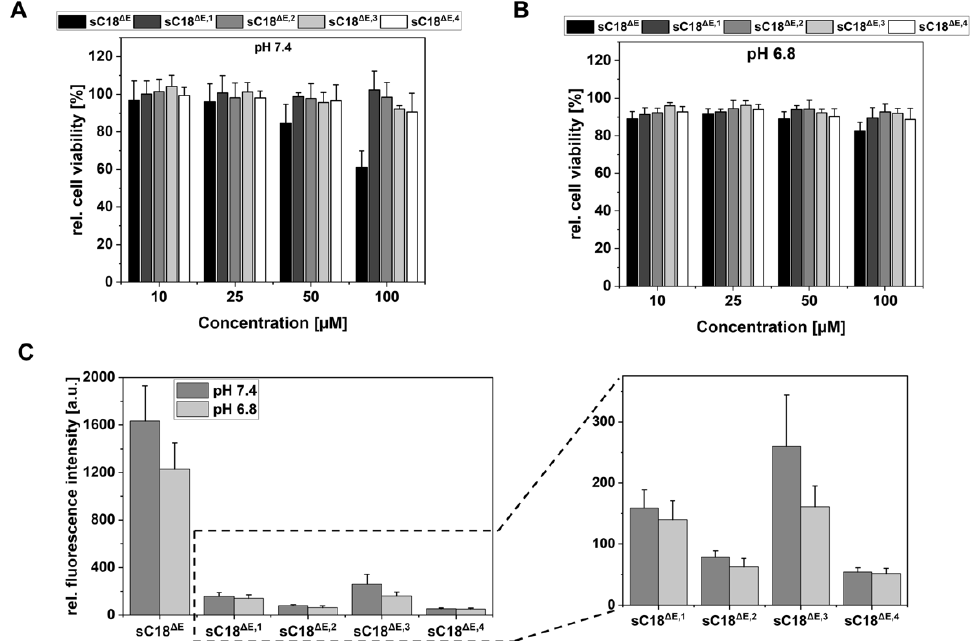
Figure 1. ( A,B ): Cell-viability assays using MCF-7 cells. Cells were cultivated at pH 7.4 or pH 6.8, respectively, for 24 h using different concentrations of peptide solutions. Untreated cells served as negative control; cells treated with 70% ethanol as positive control. Values from the positive control were subtracted from all data, and the untreated cells were set to 100%; assays were conducted in triplicate n = 3. ( C ): Cellular uptake of histidine peptides in MCF-7 cells. Cells were cultivated at different pH-values and incubated with 10 µM peptide solutions for 30 min at 37 °C; assays were conducted in triplicate n = 3.